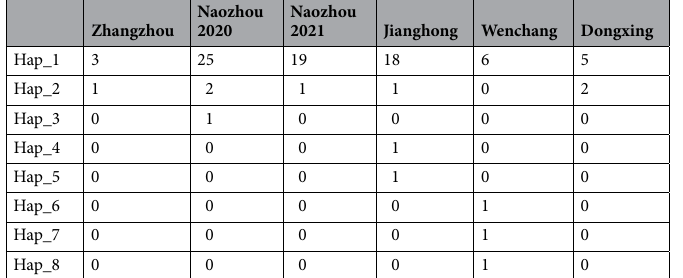
Table 2. Frequency of haplotypes in each sampling locations. Numbers indicate the number of individuals with this haplotype in the